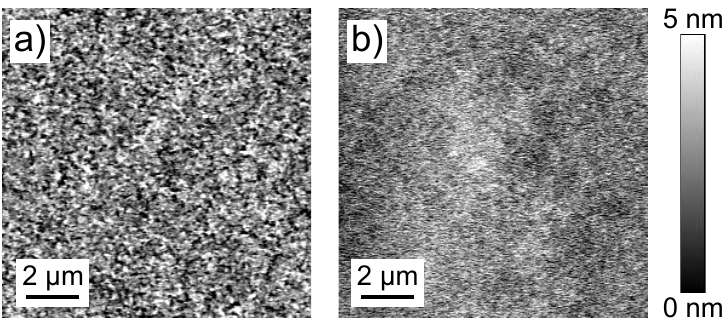
Figure 4. AFM images for gold films prepared by the ( a ) post-deposition cured recipe and ( b ) pre-deposition cured recipe on 20 µ m thick SU-8 layers. The morphologies and hence roughness values are different.